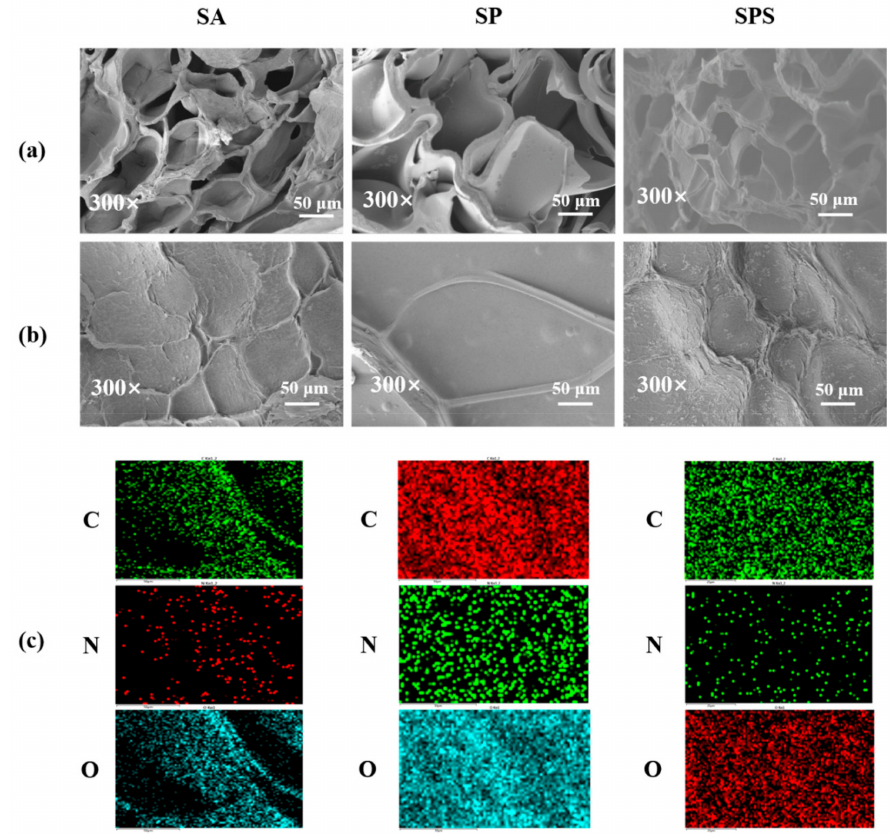
Figure 4. The ( a ) cross-section, ( b ) surface microstructure and ( c ) surface energy dispersive spectrum (EDS) of the SA, SP and SPS hydrogel sphere observed by scanning electron microscopy